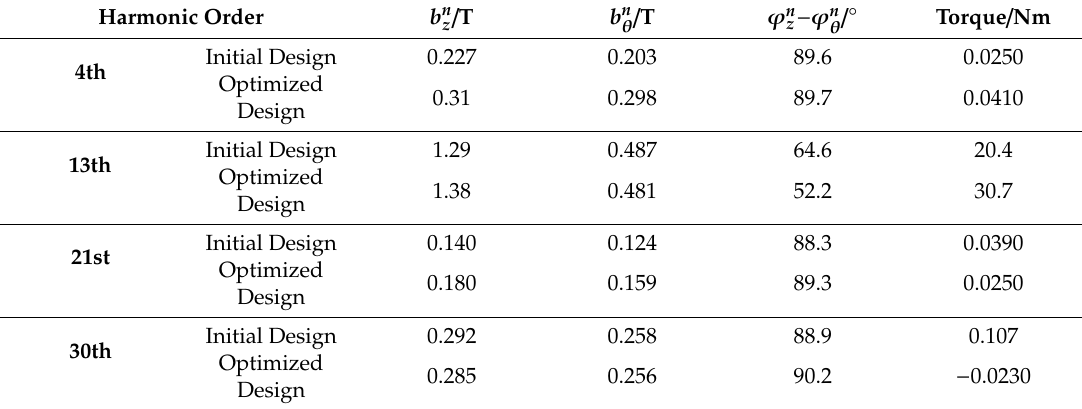
Table 9. Amplitudes, phase di ff erences and torque due to the air-gap flux density at the radius of R m3 . Harmonic